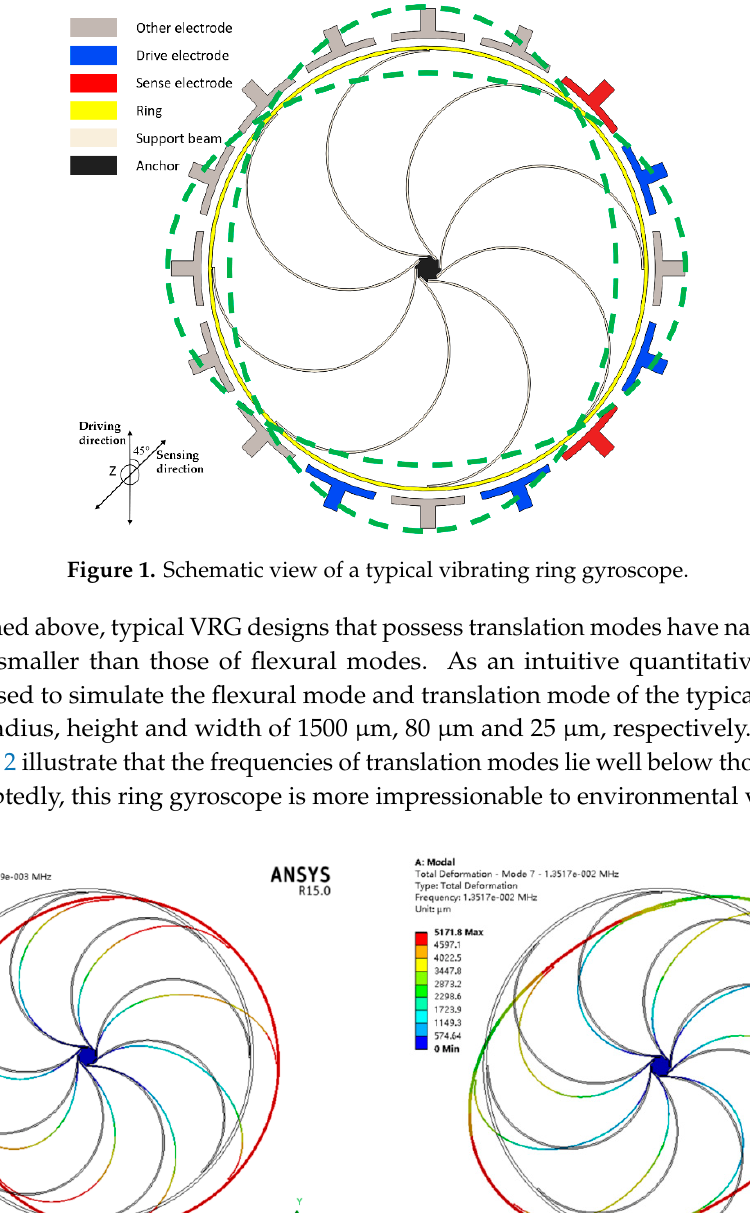
Figure 2. Modal analysis of the translation mode ( a ) and flexural mode ( b ) of a typical vibrating ring gyroscope.